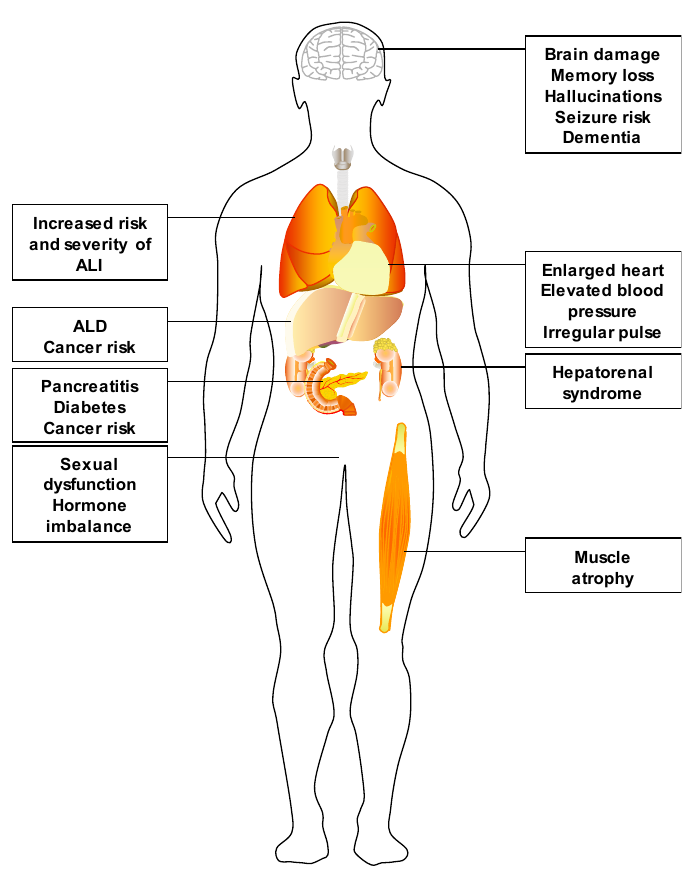
Figure 1. Organs targeted by alcohol abuse. Alcohol abuse is known to injury several organs in the human body, including liver, brain and pancreas. Furthermore, alcohol abuse is associated with dysfunction/injury in several other organs, such as the lungs, muscles and respiratory tract. It is likely that the metabolic demand of metabolizing pharmacologically-relevant (mM range) concentrations of alcohol explains, at least in part, the broad impact of this toxin. ALD: alcoholic liver disease; ALI: acute lung injury.